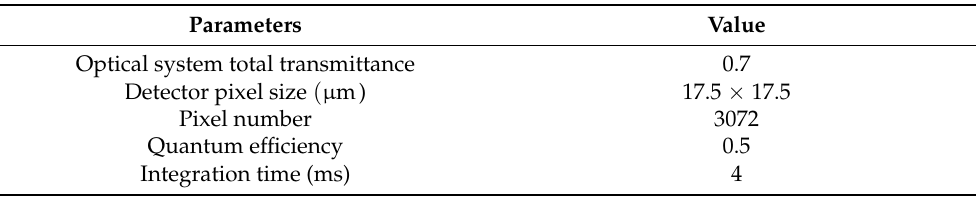
Table 1. Fixed Simulation Parameters.